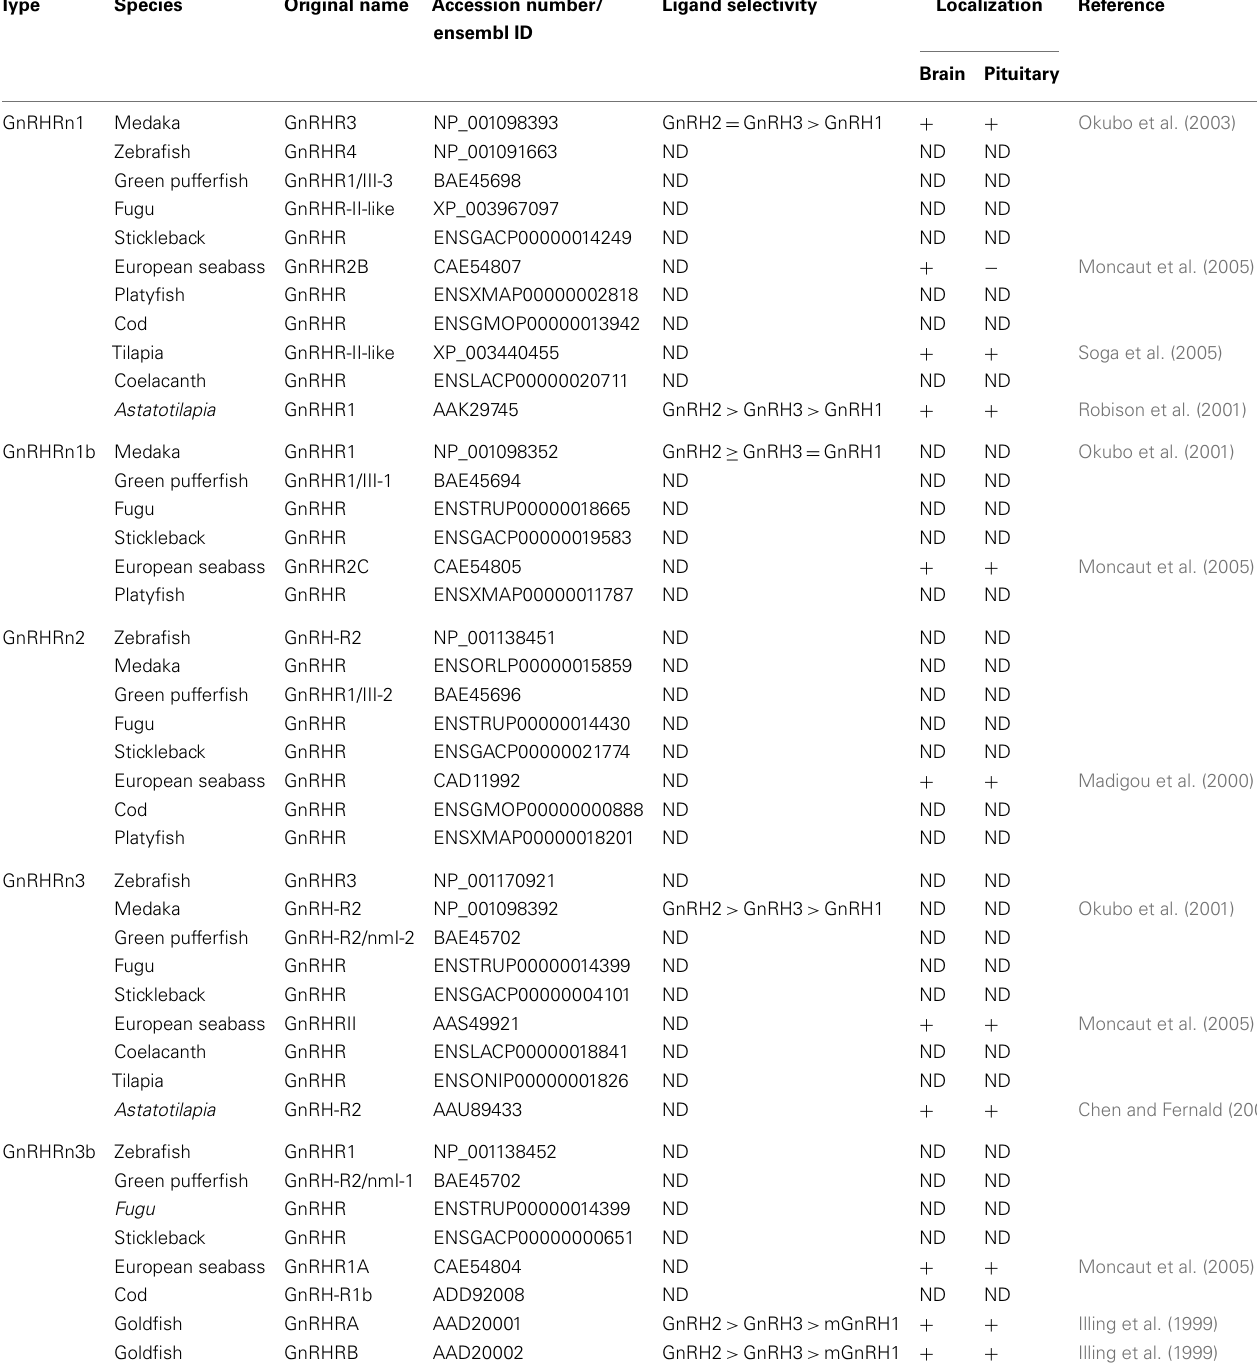
Table 1 | GnRH receptors in